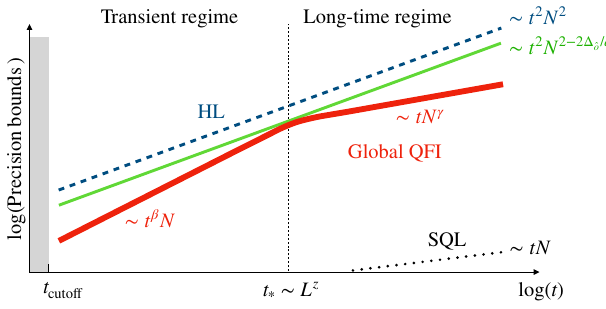
FIG. 2. Illustration of the universal scaling laws of the global QFI at a generic dissipative CP, Eqs. (12) and (13), with respect to the interrogation time t and the particle number N ≡ L d , assuming that d ≥ 1. The global QFI (red solid line) and its tight bound, Eq. (14) (green solid line), are contrasted with the HL (blue dashed line) and the SQL (black dotted line). The char- acteristic time scale t ∗ ∼ L z separates the transient regime and the long-time regime, where the global QFI obeys different scal- ing laws. The scaling exponents are determined by the spatial dimension d , the dynamic critical exponent z and the scaling dimension (cid:10) ˆ o of the local operator ˆ o i that encodes the unknown parameter, via β = 2 + ( d − 2 (cid:10) ˆ o )/ z and γ = 2 + ( z − 2 (cid:10) ˆ o )/ d . The shaded region represents an initial time window character- ized by a short cutoff time scale t cutoff , in which the behavior of the global QFI is not